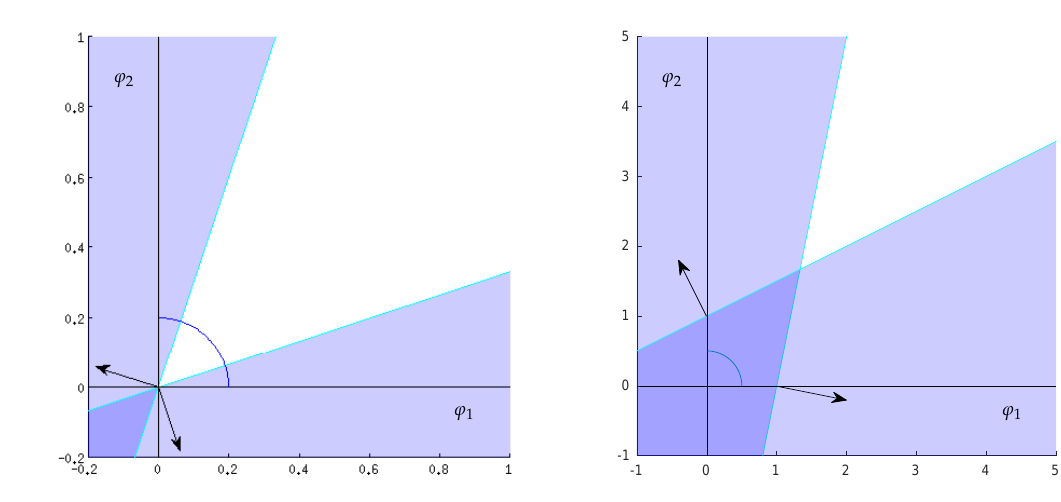
Figure 2. Two hyperplanes and the set ∂ B ε ( 0 ) ∩ Λ ε